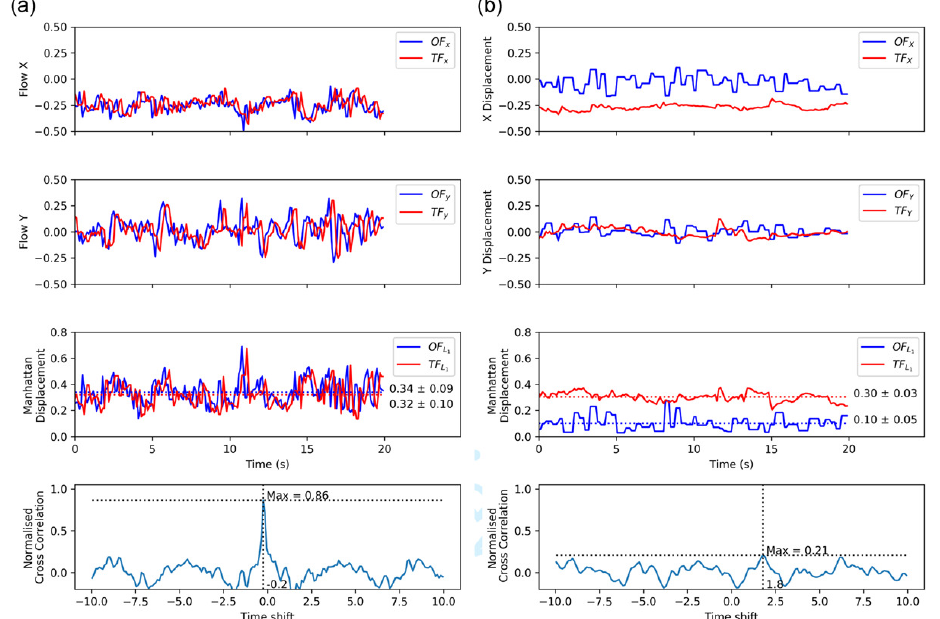
Figure 6. Optical flow (OF) and thermal flow (TF) comparison during ( a ) day and ( b ) night flights. ( a , b ) Each include four plots. From the top to bottom sections are the following: OF and TF X-axis angular displacement (radians/second); OF and TF Y-axis angular displacement (radians/second); OF and TF Manhattan distance angular displacement; and Normalized cross-correlation of the OF and TF Manhattan distance displacement signals (dimensionless). Results for the day flight shows high correlation between optical and thermal values, while the night flight shows low correlation as visible spectrum OF is degraded in low light